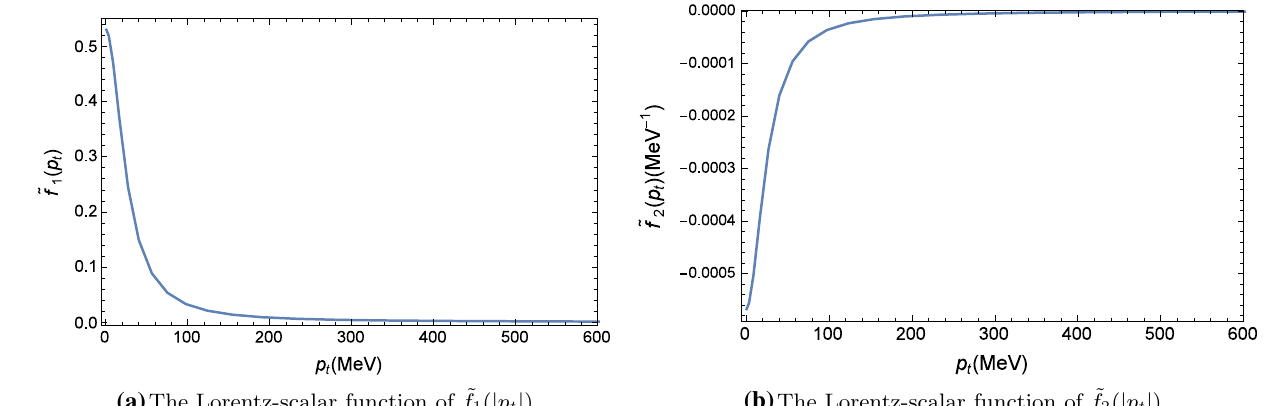
The Lorentz-scalar function of ˜ f 1 ( | p t | ) Fig. 1 Numerical results for the Bethe–Salpeter wave functions in the (cid:3) ¯ K system